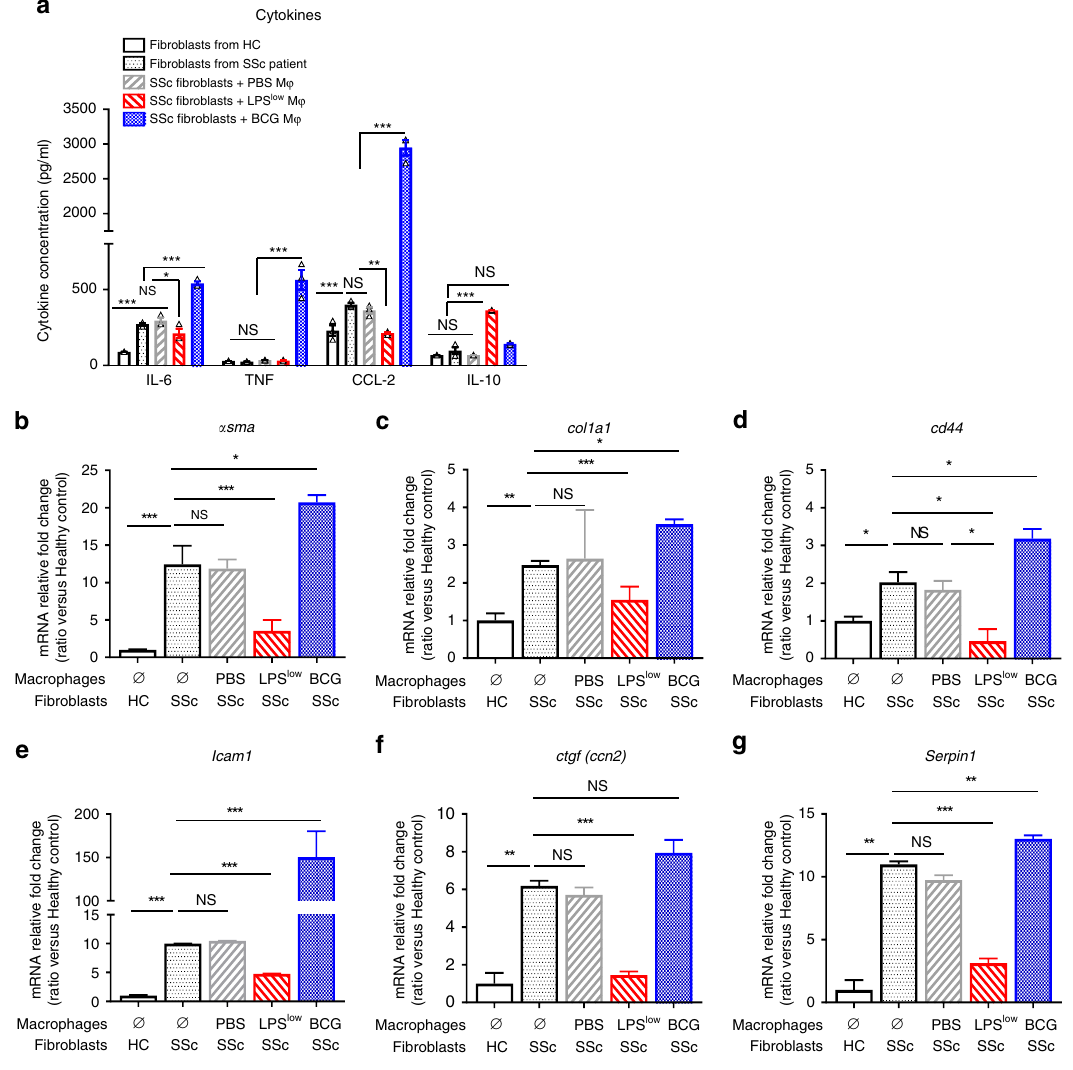
Fig. 6 Effect of trained macrophages on fi broblasts in patients with SSc. a Levels of IL-6, TNF, CCL-2, and IL-10 in co-culture supernatants. Supernatant was collected after 48 h of co-culture incubation. Cytokine production was assessed by ELISA (pg/mL). Each box represents mean ± SEM of n = 3 biologically independent samples. The ANOVA test with Bonferroni correction was used to detect signi fi cant differences between the groups. NS: Not signi fi cant; * p ≤ 0.05; ** p ≤ 0.01; *** p ≤ 0.001. b – g RT-qPCR assessment of α -sma , Col1a1 , Cd44 , Icam-1 , Ctgf , and Serpin1 mRNA levels, after 48 h of co- culture. Results were expressed as fold increase versus the fi broblast from HC condition, derived from n = 3 biologically independent samples. Unpaired T -test was used to detect the signi fi cance. M ϕ : Macrophages. NS: Not signi fi cant; * p ≤ 0.05; ** p ≤ 0.01; *** p ≤ 0.001. Source data are provided as a Source Data fi